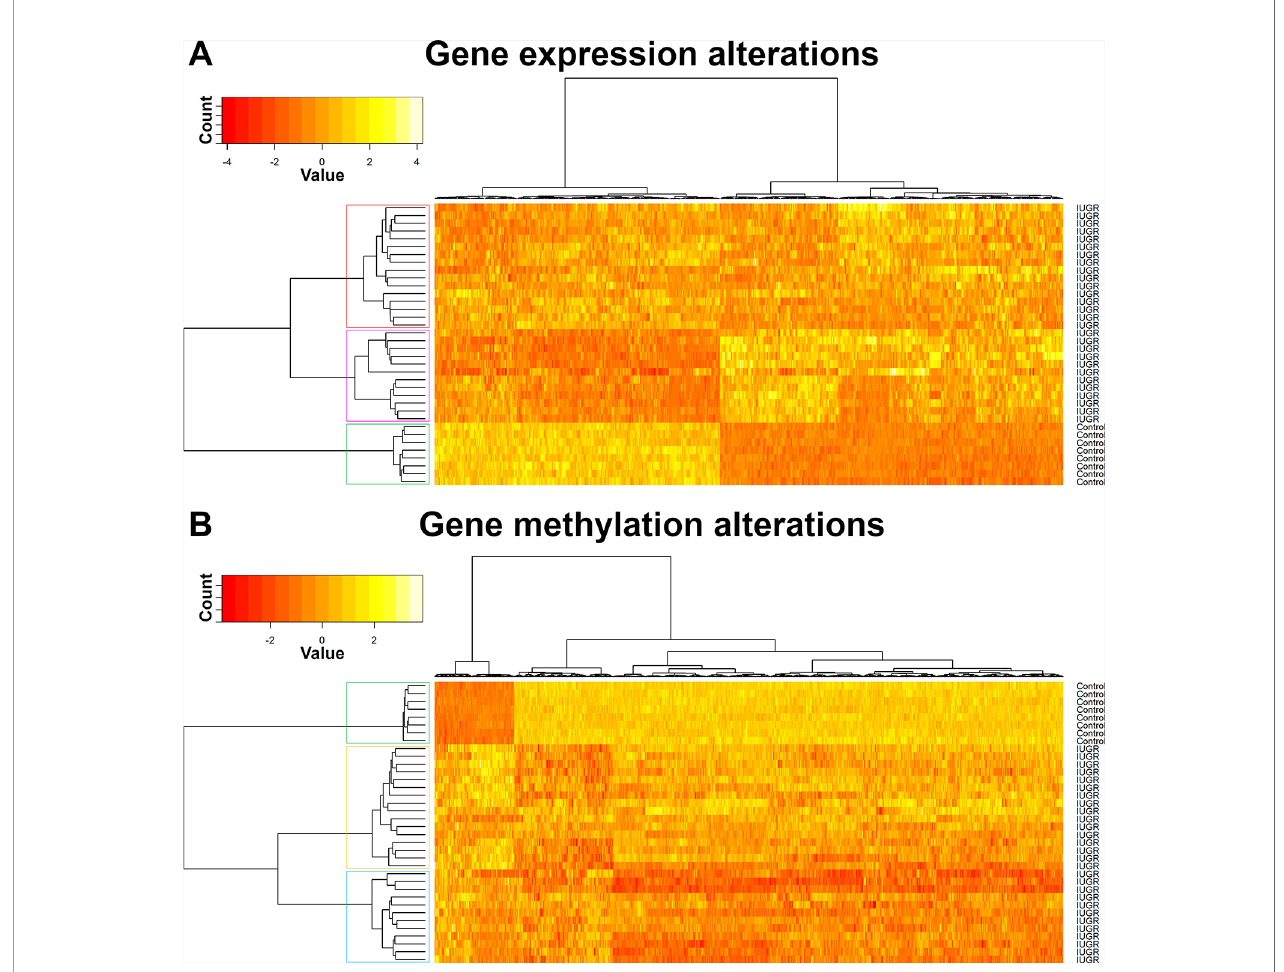
FIGURE 2 | Hierarchical clustering of samples, gene expression (A) and methylation (B)